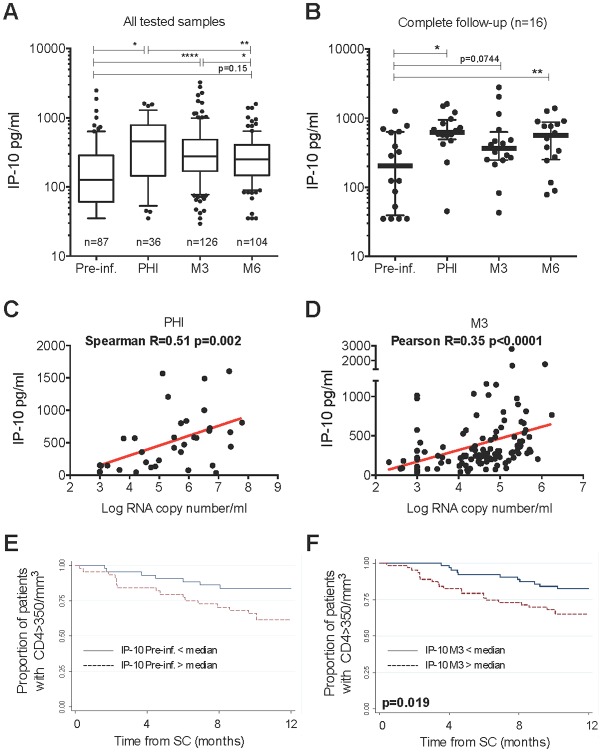
CXCL10/IP-10 dynamics in blood before HIV-1 infection and during the early infection, and its impact on the CD4 T-cells count.IP-10 levels were determined in sera from HIV+ individuals enrolled in the Amsterdam Cohort Studies on HIV/AIDS. A. Plasma IP-10 levels. The numbers of patients per group are indicated. B. Longitudinal follow-up of the same 16 individuals. C. Positive correlation between IP-10 concentrations and viremia at PHI. D. Positive correlation between IP-10 concentrations and viremia at M3 post SC. E. Impact of pre-infection blood IP-10 concentrations on the CD4 T-cells count after seroconversion. F. Impact of M3 blood IP-10 concentrations on the CD4 T-cells count after seroconversion. E and F: Kaplan Meier survival analysis. Pre-inf. = Pre-infection (median 11 months before seroconversion), PHI = Primary HIV-1 infection, M3 and M6 = 3 and 6 months post seroconversion. * p<0.05, ** p<0.001, **** p<0.00001